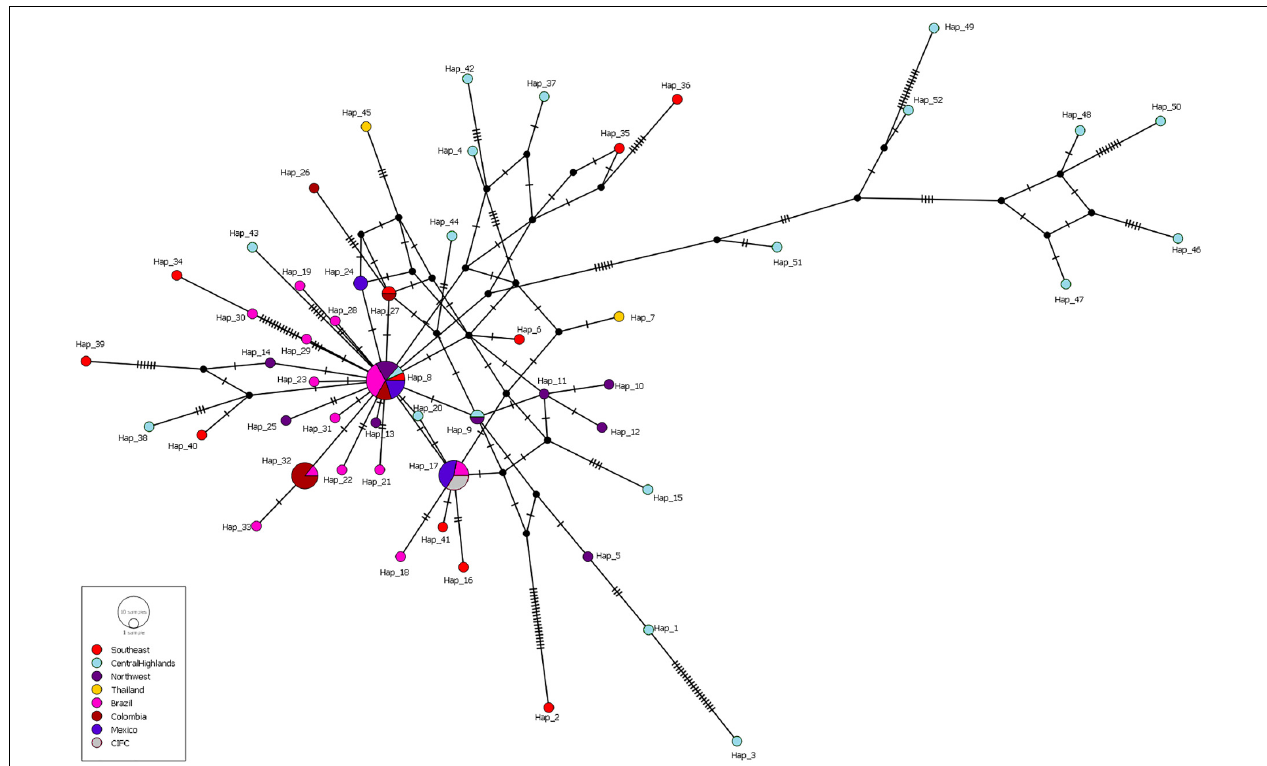
FIGURE 2 | Median-joining haplotype network inferred from the ITS regions of Hemileia vastatrix sampled from Vietnam, Thailand, Portugal, and other countries in America (Brazil, Colombia, Mexico). Circles represent haplotypes, with bright red corresponding to samples collected from Southeast Vietnam, light turquoise the Central Highlands of Vietnam, purple the Northwest of Vietnam, while yellow indicates Thailand, pink Brazil, brick red Colombia, dark blue Mexico, and grey CIFC (Portugal). The size of the circles is proportional to the number of sequences in each haplotype, one transverse line represents simple mutations, and black nodes are non-sampled